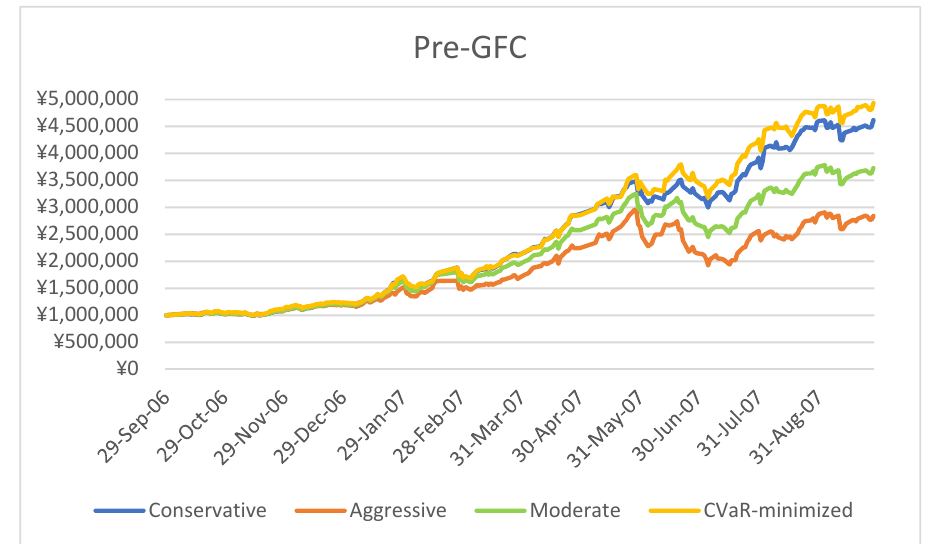
Figure 2. Cumulative gains from four investment schemes in the pre-GFC period.